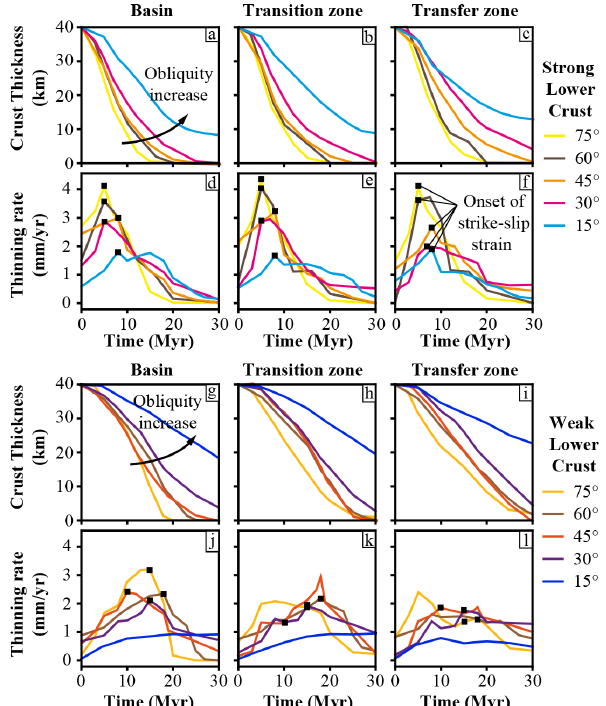
Figure 10. Curves of crustal thickness in (a,g) basins, (b,h) tran- sition zones, and (c,i) transfer and strike-slip zones for strong- and weak-lower-crust models. Curves of crustal thinning rate computed as the time derivative of crustal thickness for (d,j) basins, (ek) tran- sition zones, and (f,l) transfer and strike-slip zones for strong- and weak-lower-crust models at different